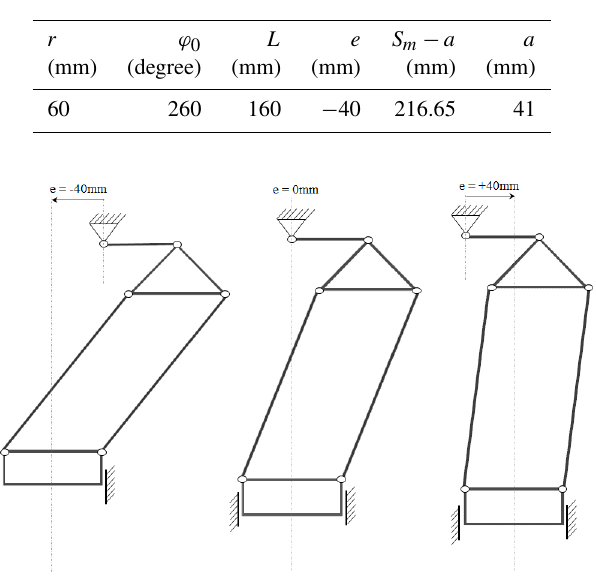
Figure 4. Three different eccentricity